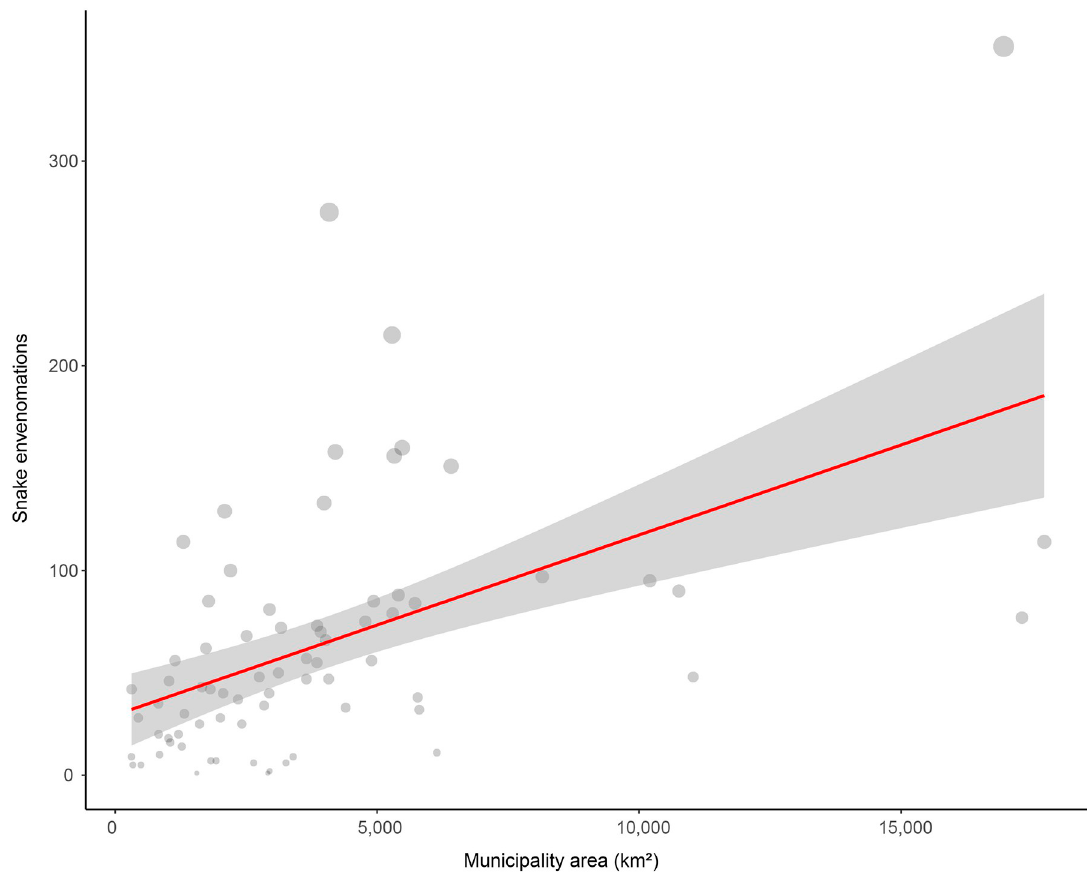
Fig 5. Relationship between the number of snake envenomation between 2007 and 2017 and the municipality area (Z = 4.26, p � 0.01) of cities from Mato Grosso do Sul state (Brazil).